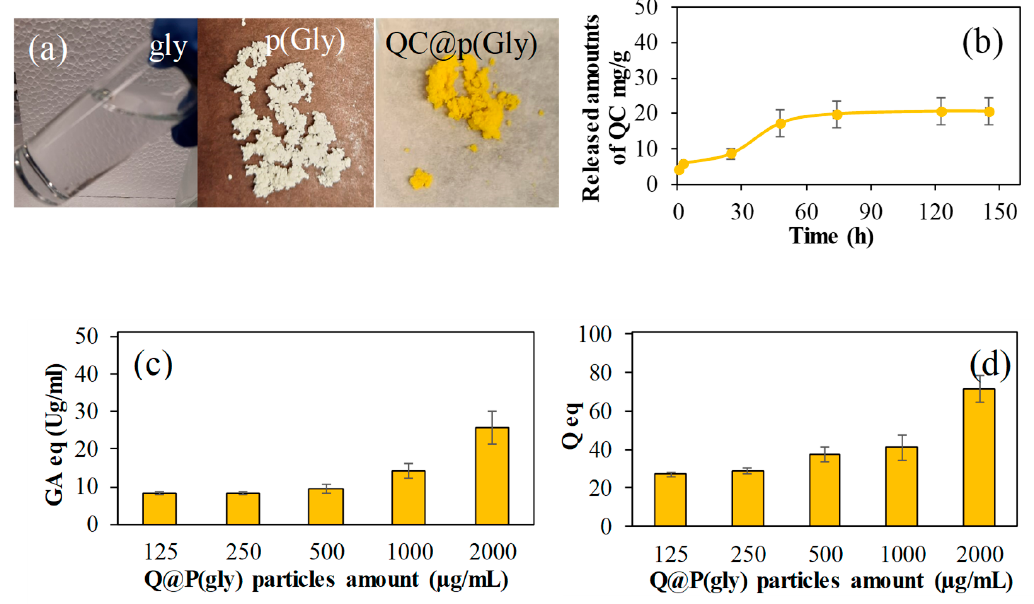
Figure 6. ( a ) Photograph images of Glycerol, p(Gly) and Q@p(Gly) particles, ( b ) in vitro drug release of Q@p(Gly) particles in PBS at pH 7.4, ( c ) Total phenol GA equivalency of Q@p(Gly) particles at different concentrations, and ( d ) Total flavonoid equivalency (Q eq) for Q@p(Gly) particles at different concentrations.